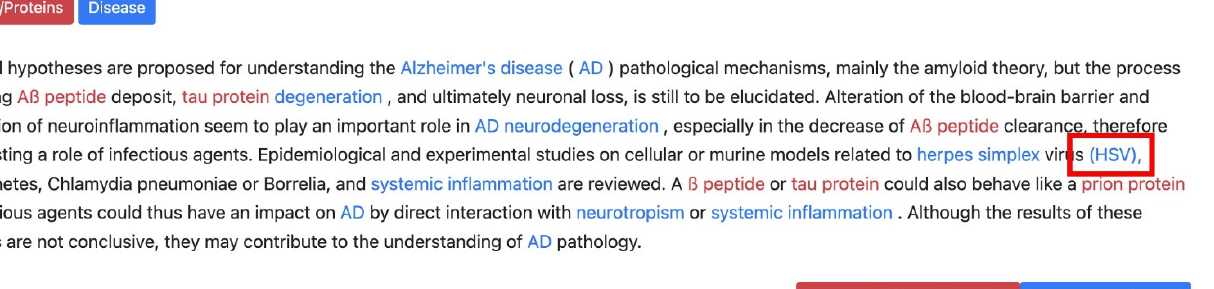
10 of 14 Figure 8. Proposed Web Interface of NER and RE with BERT using tagging tool system. ( a ) It is a word chosen by the user to form NE. ( b ) It is a user interface for categorizing the selected term. ( c ) It is a category-adding button. New NE annotations are generated using the tagging tool as follows. To add a new annotation to textual data in the NER results, users must click the beginning and end of